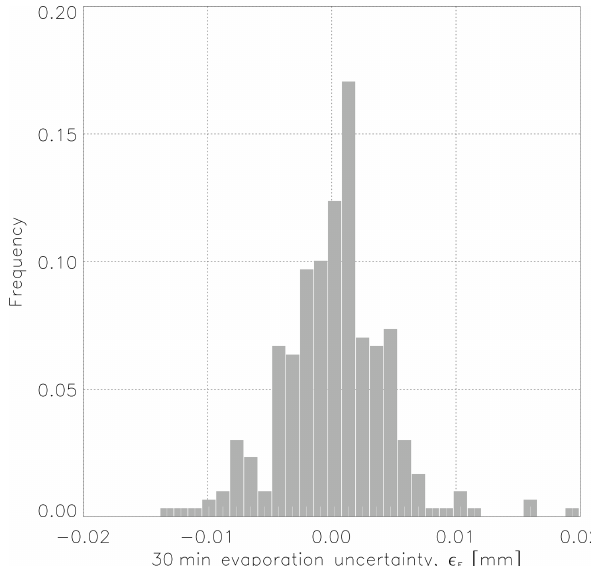
Figure A3. Frequency distribution of the 30min evaporation ran- dom instrument uncertainty ( ε F